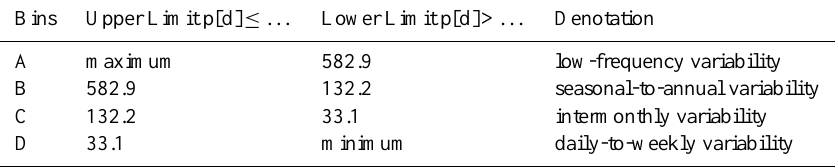
Table 2. Limits of the two frequency binning schemes. Bins Upper Limit p[d] ≤ ... Lower Limit